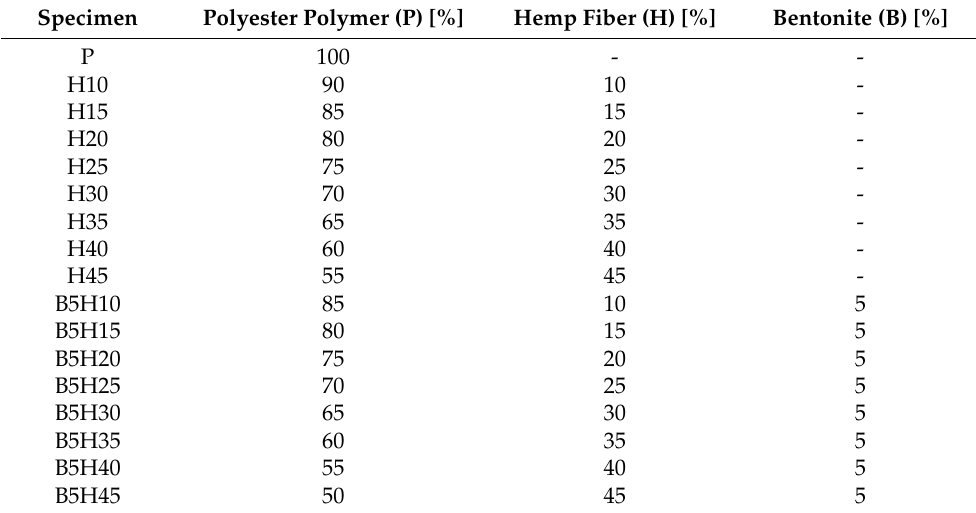
Table 2. Nomenclature of the samples.